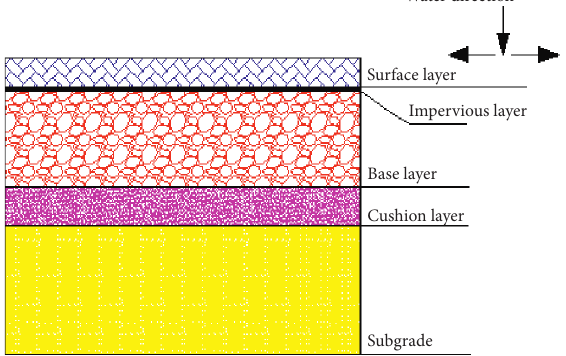
Figure 3: Drainage pavement structure.